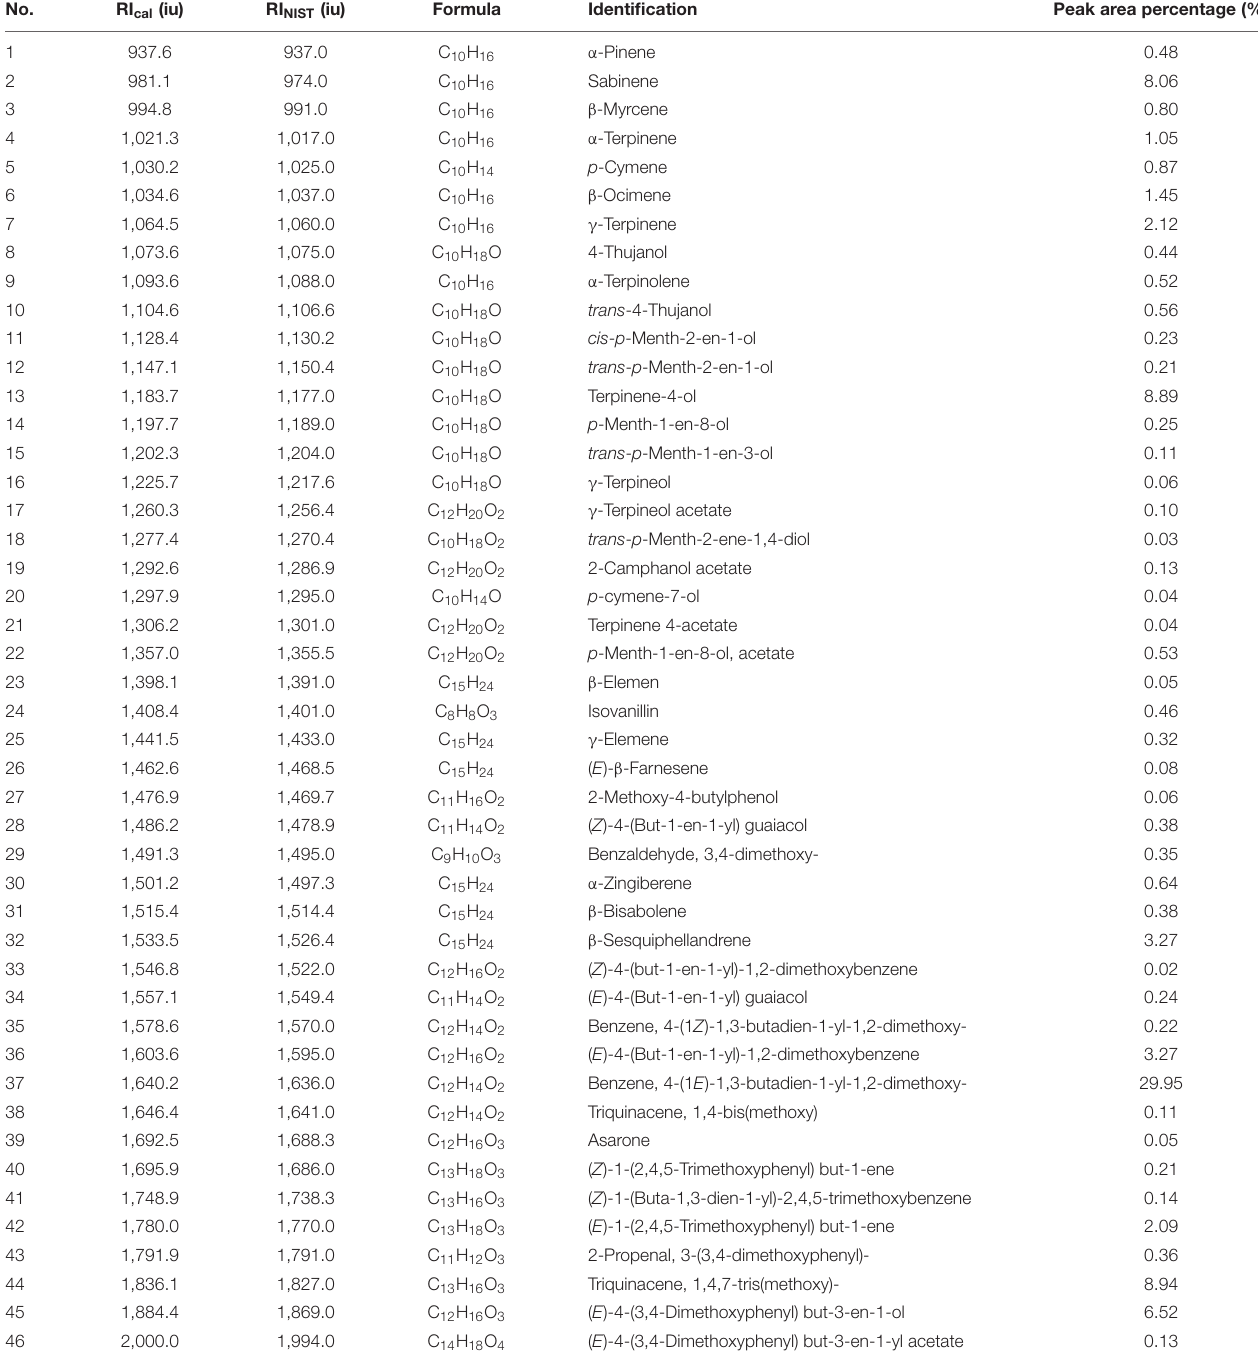
TABLE 5 | The Characterization of volatile oil ingredients in Z. montanum by GC-MS.